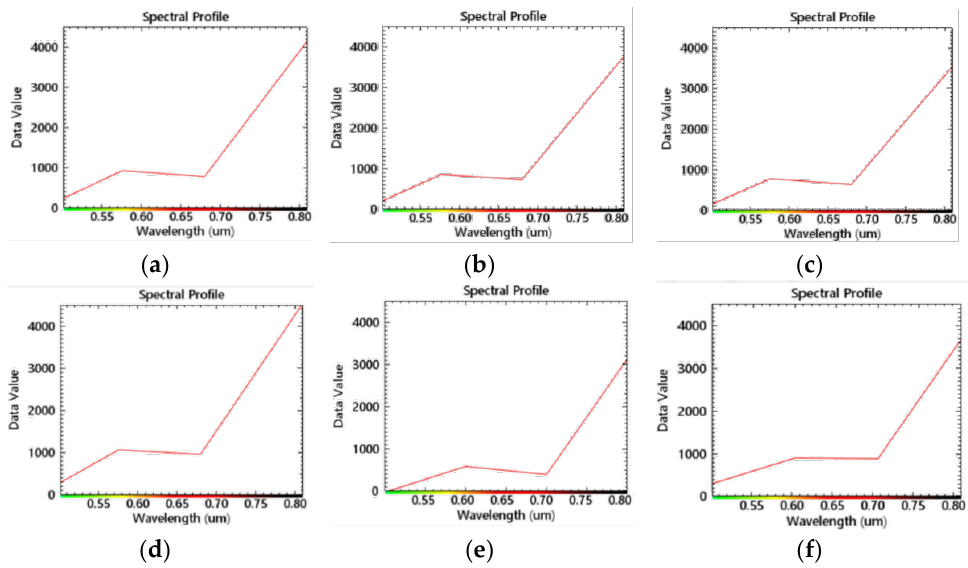
Figure 3. The vegetation spectrum curves of different fusion images. ( a ) MS image; ( b ) GS fusion image; ( c ) PCA fusion image; ( d ) NND fusion image; ( e ) Pansharpening fusion image; ( f ) HPF fusion image.